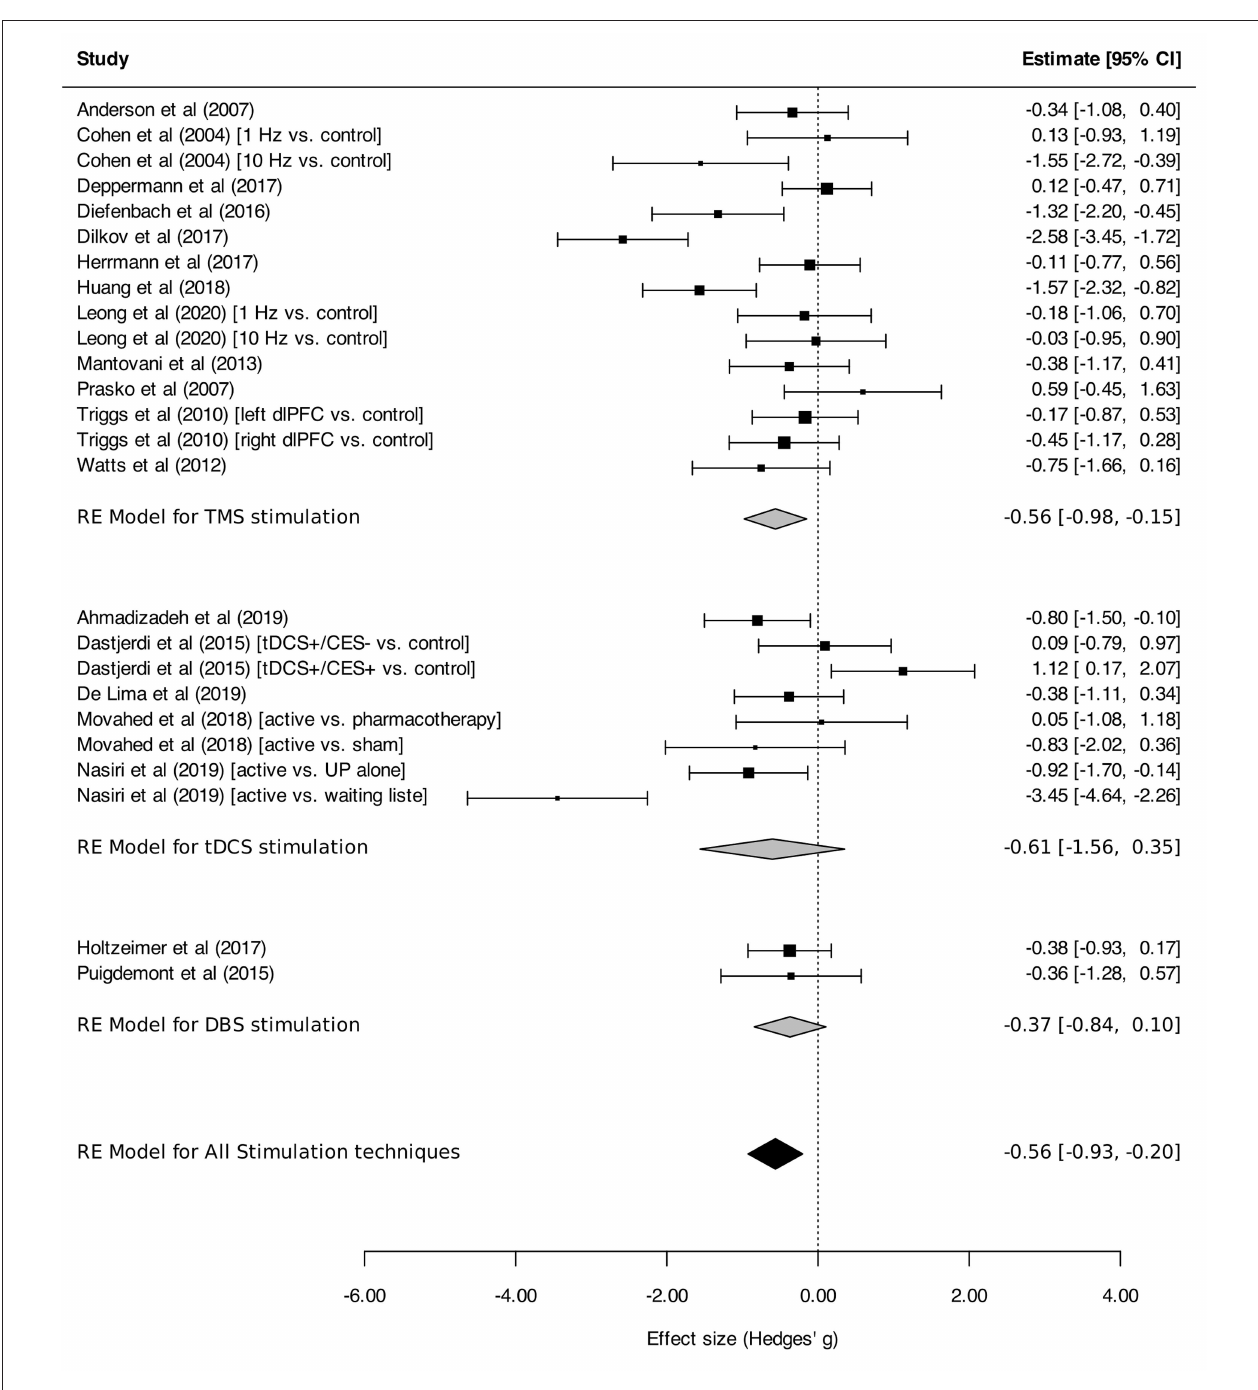
FIGURE 2 | Change in the anxiety symptoms intensity in anxiety, stressor-related disorders and MDD, subgroups by stimulation technique. Forest plot displaying effect estimates and confidence intervals for both individual studies and overall meta-analyses. Each study is represented by a block at the point estimate of the intervention SMD, with a horizontal line extending on each side representing the confidence interval. The area of the block is proportional to the weight assigned to that study in the meta-analysis. When comparisons were made between three arms, the corresponding conditions, active or control (preceded with “vs”), are indicated between brackets. Statistics: TMS: heterogeneity Sigma1 2 = 0.00, Sigma2 2 = 0.48; Q(df = 14) = 50.8 ( p < 0.0001); I 2 = 74%; test for overall effect: Z = − 2.68 ( p = 0.007); tDCS: heterogeneity Sigma1 2 = 0.53, Sigma2 2 = 0.79; Q(df = 7) = 39.6 ( p < 0.0001); I 2 = 86%; test for overall effect: Z = − 1.24 ( p = 0.21); DBS: heterogeneity Sigma1 2 = 0.00, Sigma2 2 = 0.00; Q(df = 1) = 0.001 ( p < 0.97); I 2 = 0%; test for overall effect: Z = − 1.54 ( p = 0.12); Total: heterogeneity Sigma1 2 = 0.20, Sigma2 2 = 0.37; Q(df = 24) = 90.8 ( p < 0.0001); I 2 = 77%; test for overall effect: Z = − 3.0599 ( p = 0.002); test for subgroup differences: F(df1 = 2, df2 = 22) = 0.05, p = 0.95.